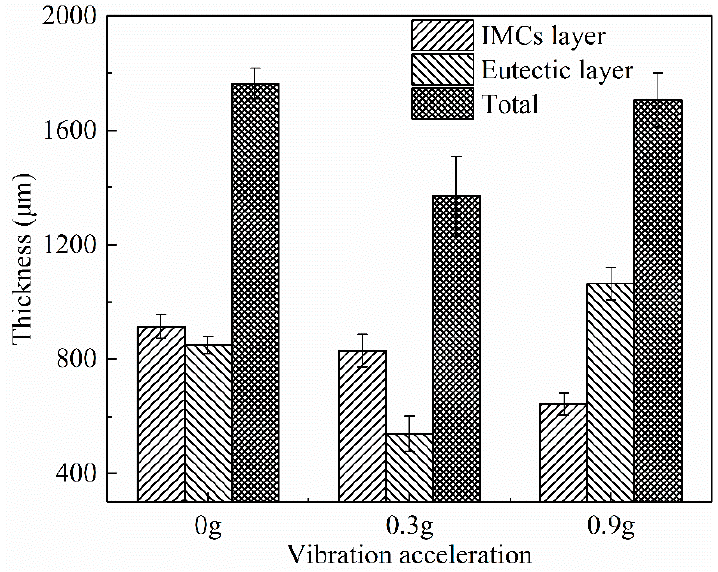
Figure 6. The thicknesses of the Mg–Al interfaces obtained with different conditions.